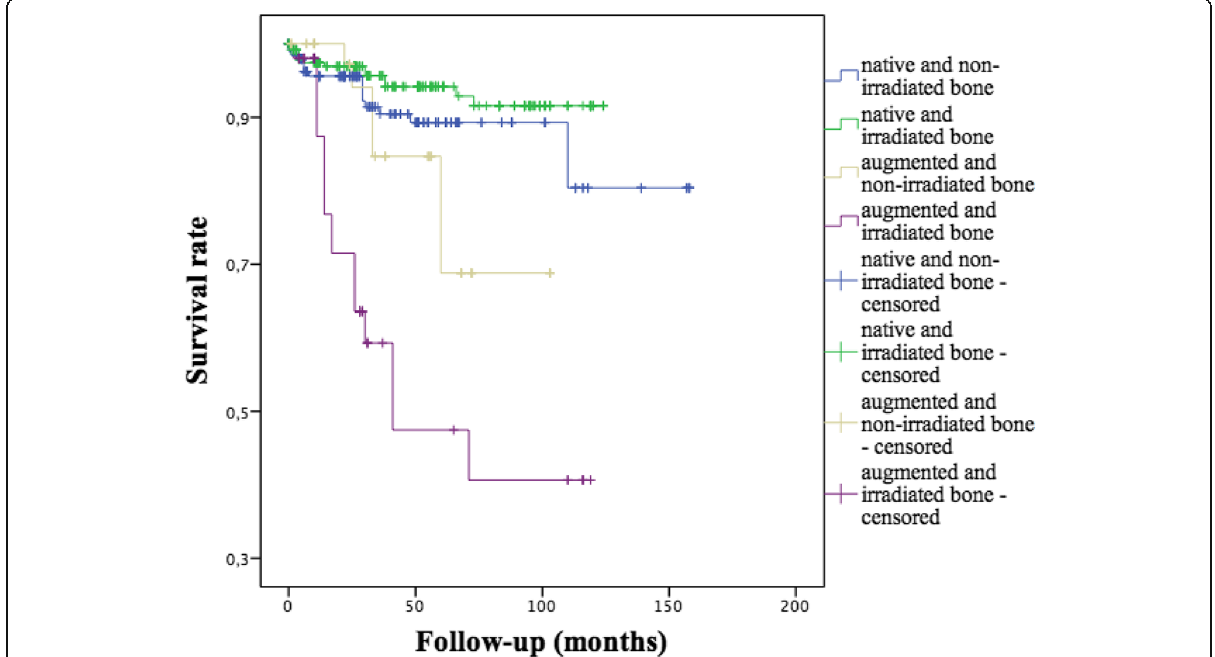
Fig. 2 The influence of the implant site (native bone vs. augmented bone) and irradiation (non-irradiated bone vs. irradiated bone) on long-term survival (p < 0.001).